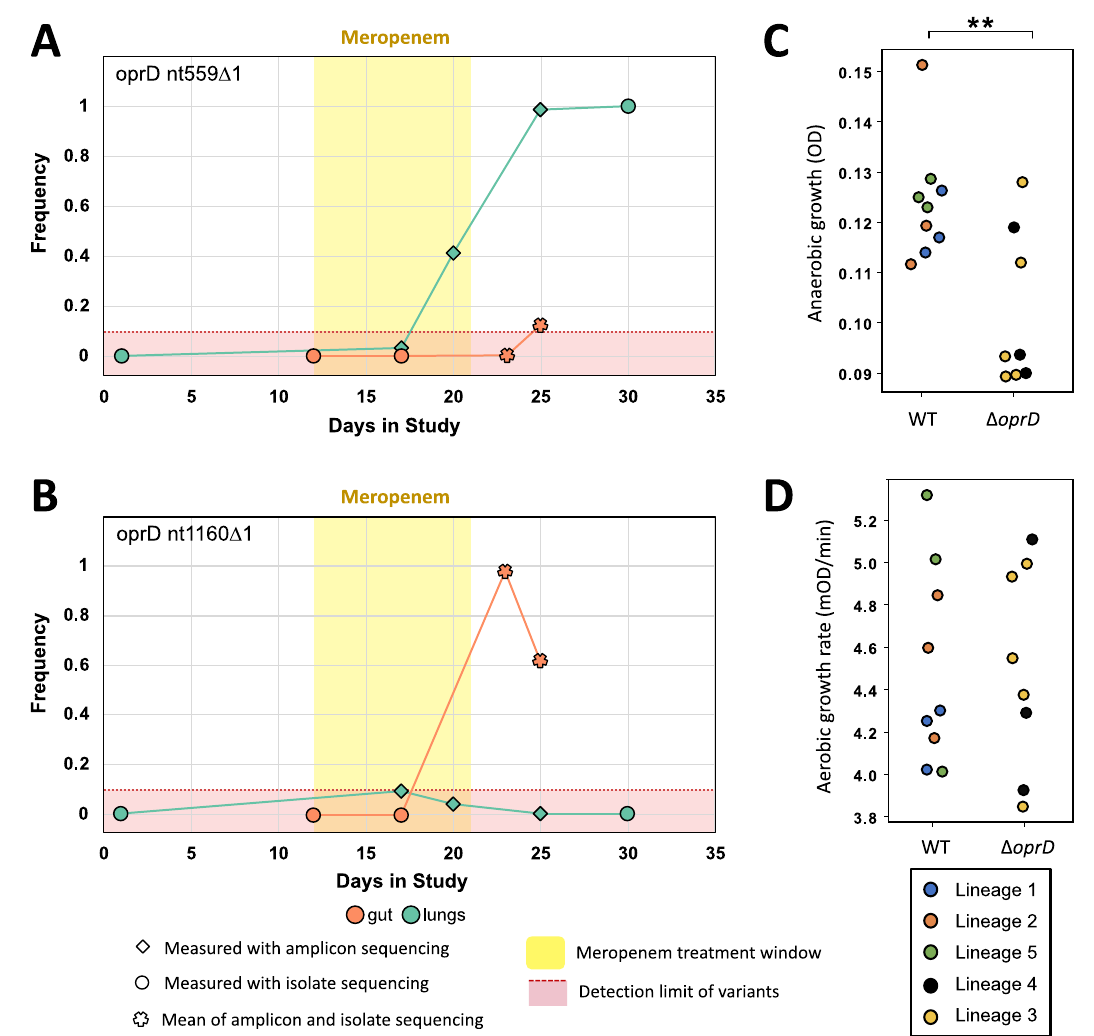
Fig. 4 | Evolution and transmission ofmeropenem resistance. A , B Dynamics of oprD variants, as determined by isolate (circle) and oprD amplicon (diamond) sequencing data. For the two sampling points (gut day 23 and gut day 25) where both amplicon and isolate sequencing was carried out, the mean of the two fre- quencies is shown(star).Measurementsof SNP frequencyfrom isolate sequencing and amplicon sequencing were strongly correlated ( R 2 =0.9963; Supplementary Fig. 3). The yellow area shows the window of meropenem treatment and the red area shows a conservative minimum detection limit of variants from amplicon sequencing due to the error rate of nanopore sequencing. C , D Growth of isolates with an o prD variant ( Δ o prD ) compared to isolates with the wild-type oprD back- ground. Anaerobic growth ( C ) was measured as OD 595 after 72hours growth in anaerobicbroth.Valuesplottedforeachpoint(i.e.isolate)arecalculatedfrom n =3